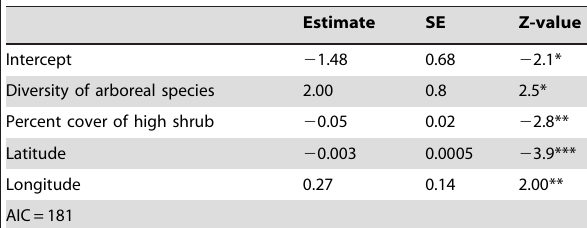
Table 2. Habitat determinants of Capercaillie occurrence and bird species diversity as highlighted by